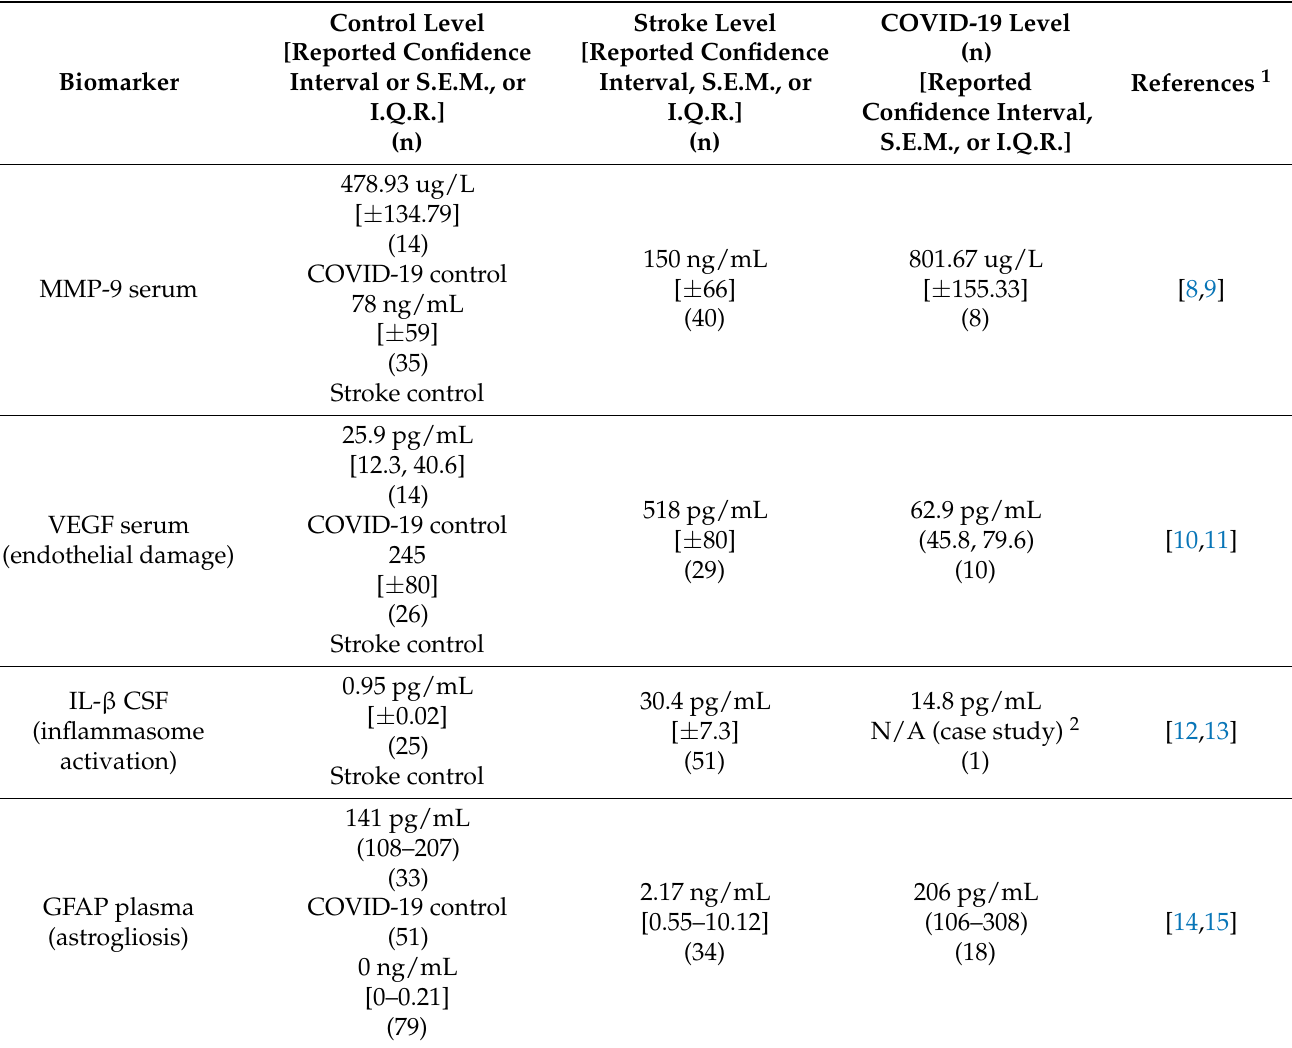
Table 1. The pathological evidence of inflammatory proteins involved in both COVID-19 and